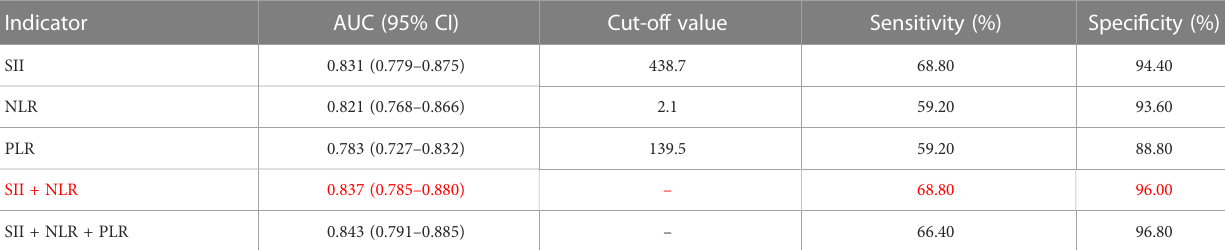
TABLE 2 Diagnostic ef fi ciency of the platelet-lymphocyte ratio, neutrophil-lymphocyte ratio, and systemic immune-in fl ammation index individually and in combination for gastric cancer patients. Indicator